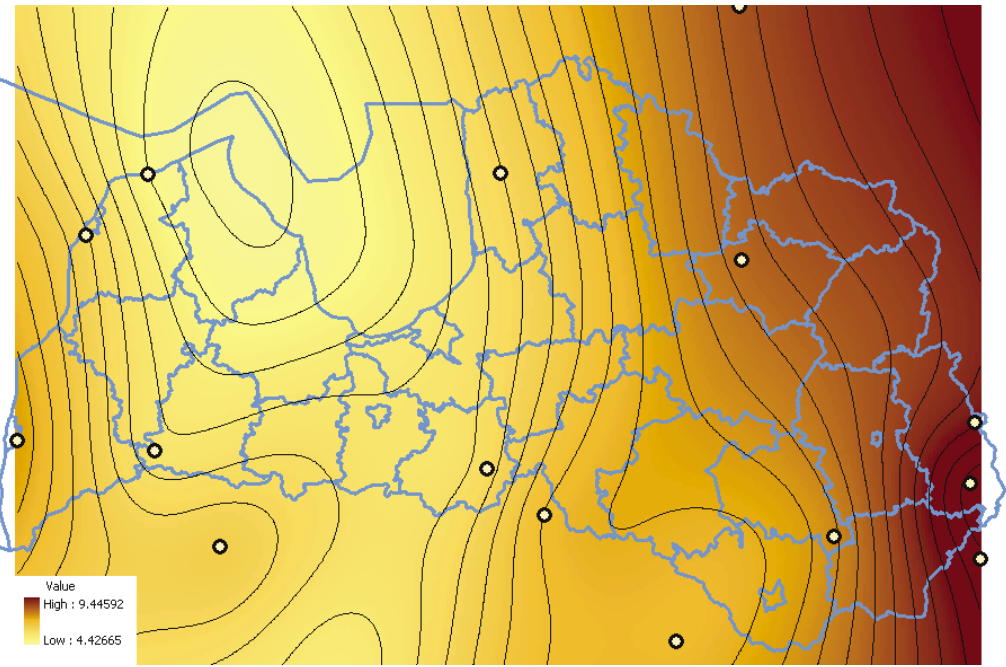
Fig. 5. Declination rates on Latvian territory varies from 4° to 8°